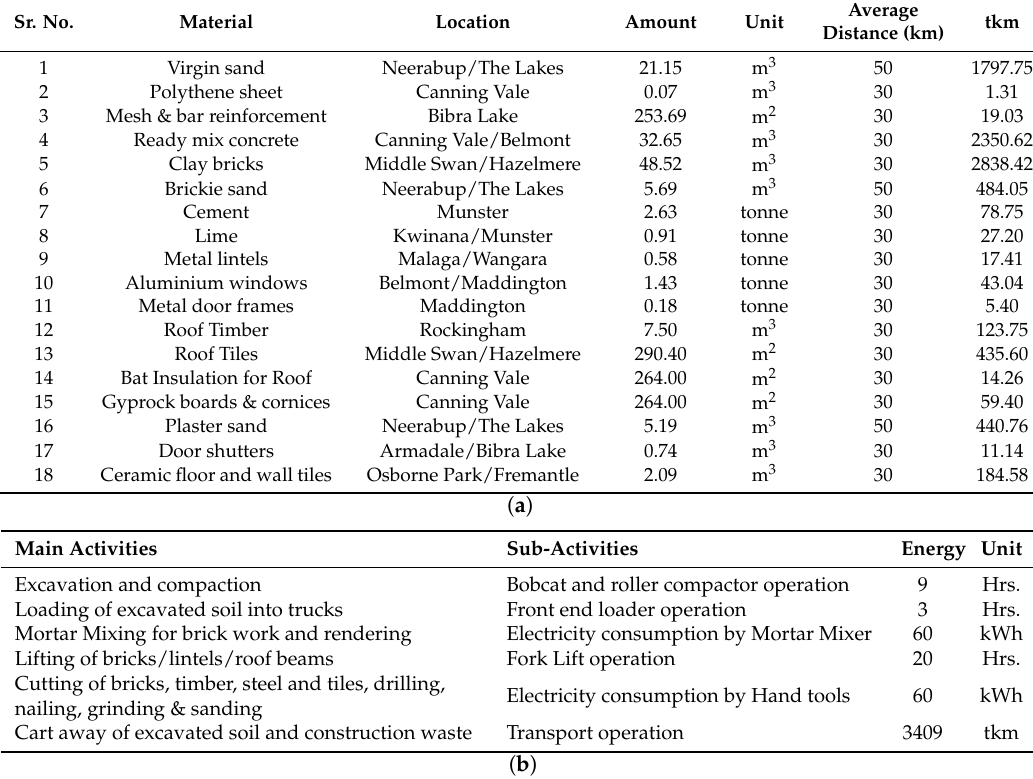
Table 1. ( a ) Materials used for the construction of the typical current practice of clay brick wall house (CBWH) in Perth; ( b ) Energy used for the construction stage of a typical CBWH in Perth. Sr.